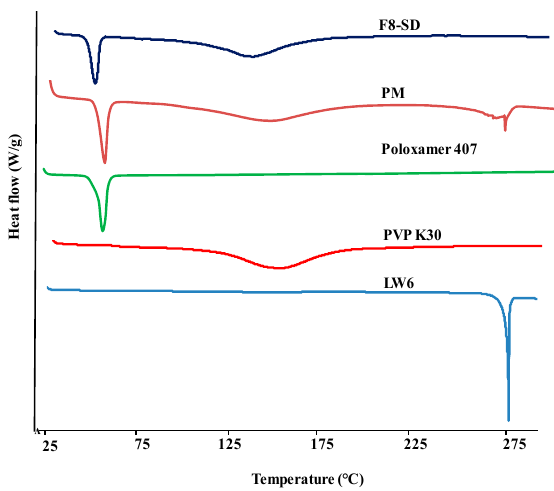
Figure 7. Differential scanning calorimetry (DSC) thermograms of drug, polymeric carriers, F8-SD, and PM.